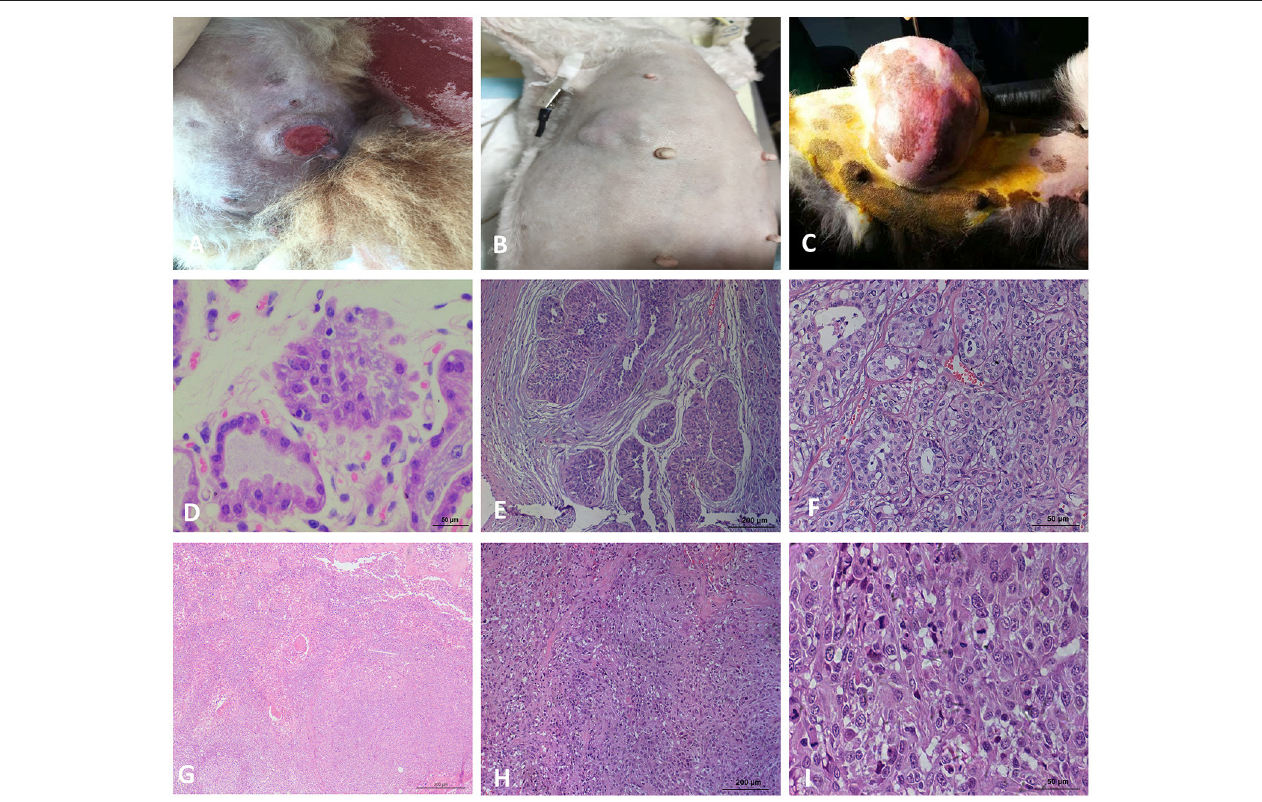
FIGURE 1 | Macroscopic observation and HE staining of CMTs. (A) Macroscopic observation of CMT, the skin surface of the tumor ruptured. (B) Macroscopic observation of CMT, a cauliflow-like mass in mammary gland with obviously boundary and hard texture. (C) Macroscopic observation of CMT, the tumor located on the mammary tissue with a great size. (D) HE staining of the breast lobules in a normal dog (400 × ). (E) HE staining of mammary gland adenoma (200 × ), the capsule is intact and tumor cells grow in the enlarged lumen. (F) HE staining of mammary gland adenoma (400 × ), Adenoma arising in the glandular tissue, myoepithelial cells are inconspicuous, the islands of neoplastic cells are separated by a fine fibrovascular connective. (G) HE staining of solid carcinoma (200 × ). (H) HE staining for ductal carcinoma (200 × ), tumor cells invaded the connective tissue, glandular ducts were disappeared. (I) HE staining for ductal carcinoma (400 × ), tumor cells are pleomorphic and